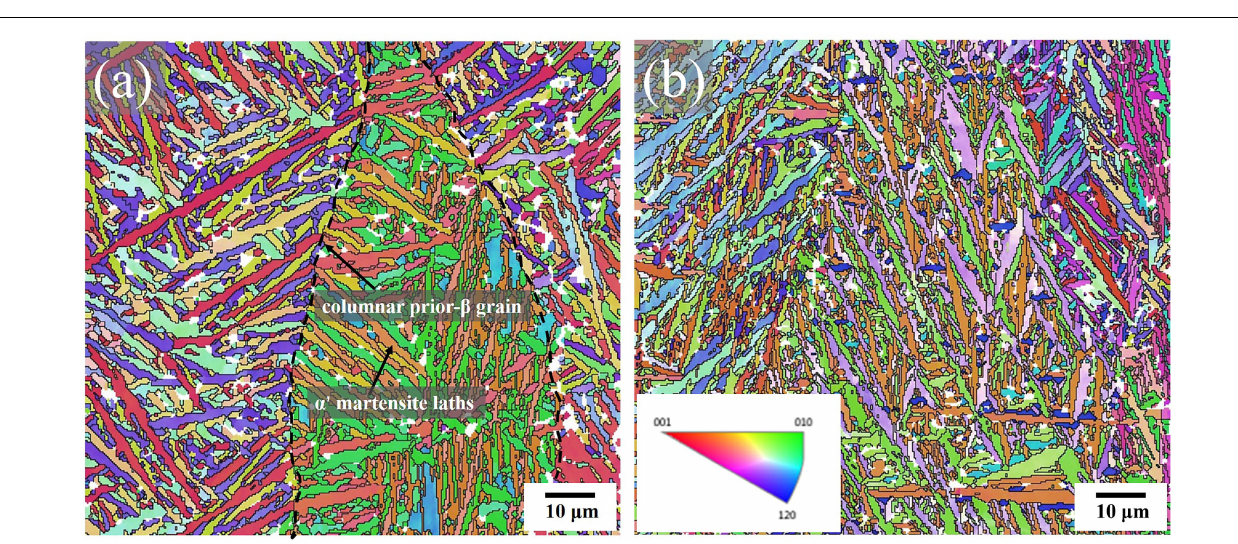
the thicker portion deformed toward the pressure side and the edges deformed toward the suction side. That indicates that the blade has a tensile stress along the two edges during SLM process. To observe the dimensional deviation distribution of the leading edge, trailing edge, and middle part of the blade, six lines were marked in these three parts of the blade as shown in Figure 8 . The line 1, line 2, and line 3 are marked on pressure surface in Figure 8A . The line 4, line 5, and line 6 are marked on suction surface in Figure 8B . The deviation direction of each point on the line taken from the pressure surface ( Figure 8A ) is exactly opposite to the corresponding part on the suction surface ( Figure 8B ), but the deviation values are similar. Therefore, the dimensional deviation on the pressure surface are analyzed predominantly. The fluctuation of the dimensional deviation value is small at the leading edge (ranged from − 0.06 to 0.04 mm, line 1) in Figure 8A . The dimensional deviation of line 1 is